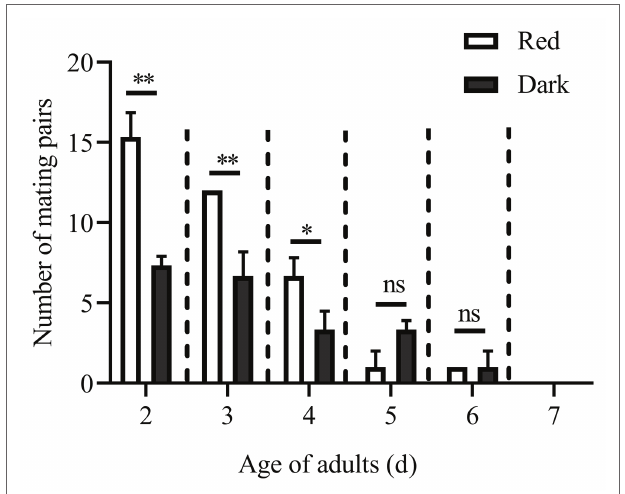
FIGURE 1 | Mating pairs of Conogethes punctiferalis under red light and dark conditions during scotophase. Data are shown as mean ± SD, from three replicates. Asterisks above columns mean significant differences ( * p < 0.05, ** p < 0.01, ns: no significant difference), by independent sample t